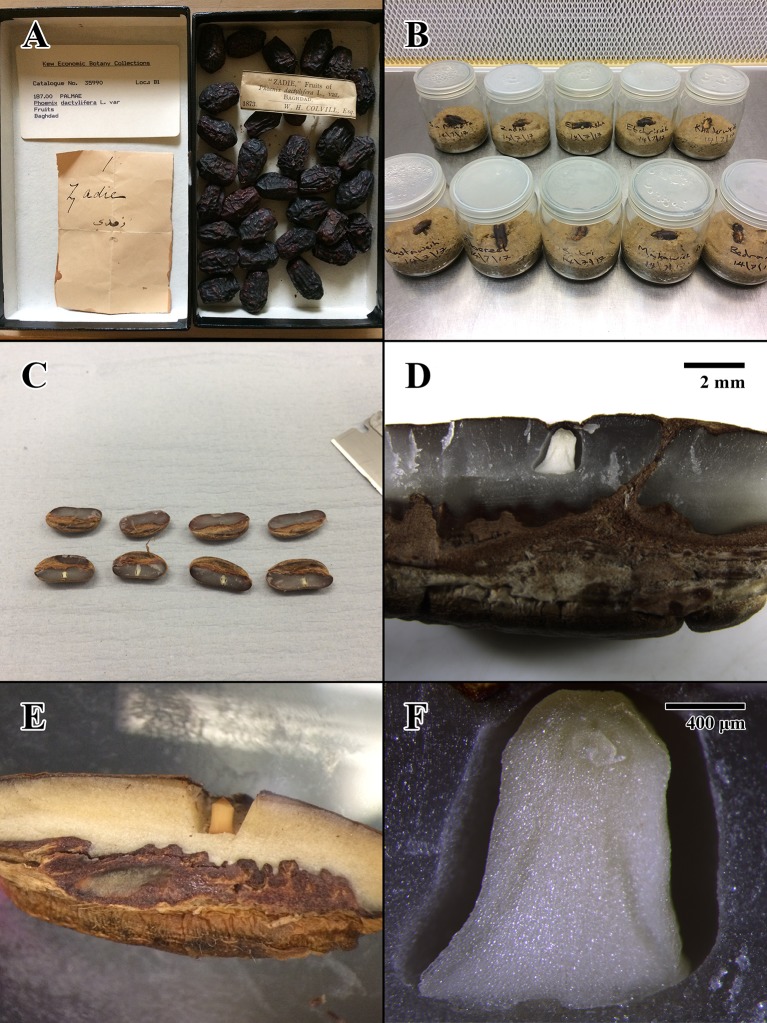
Photographs of Colvill’s original Economic Botany Collection (EBC) accession, germination tests, and physical dissection of seed lots. (A) 1873 fruits of EBC accession 35990 (“Zadie”) prior to dissection. (B) Start of germination test for EBC seeds in sterile conditions, prior to placement in incubator. (C) Physical dissection of 2004 seed lot (Millennium Seed Bank [MSB] accession no. 211945). (D) Dissection close-up of 2004 MSB seed. Scale bar = 2 mm. (E) Dissection close-up of 1873 EBC seed. (F) Compound microscope dissection close-up of 2004 MSB seed. Scale bar = 400 μm.